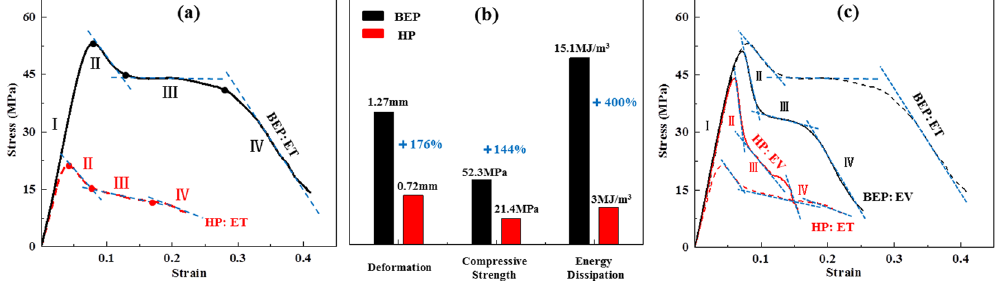
Figure 5. The experiment results of the two types of fully integrated sandwich plates. ( a ) The stress-strain curves of the core structures in the ET case. ( b ) The compressive properties of the two types of plates in the ET case. ( c ) The stress-strain curves of the core structures in the EV and ET cases. Where, the index of deformation in ( b ) is the value when those curves in ( a ) reach the position of compressive